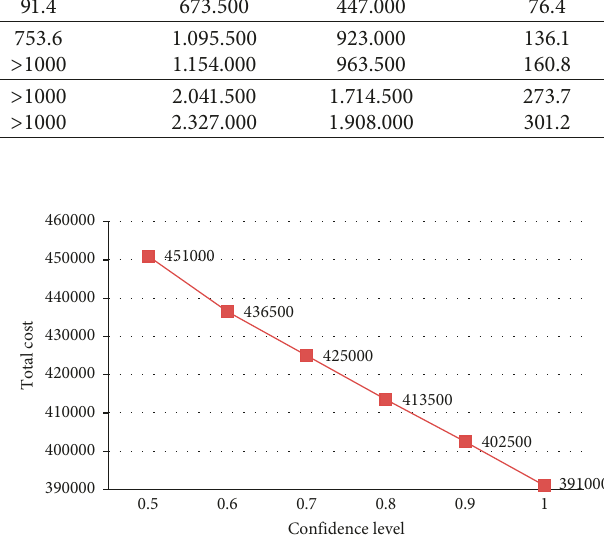
Figure 9: Computational time comparison.